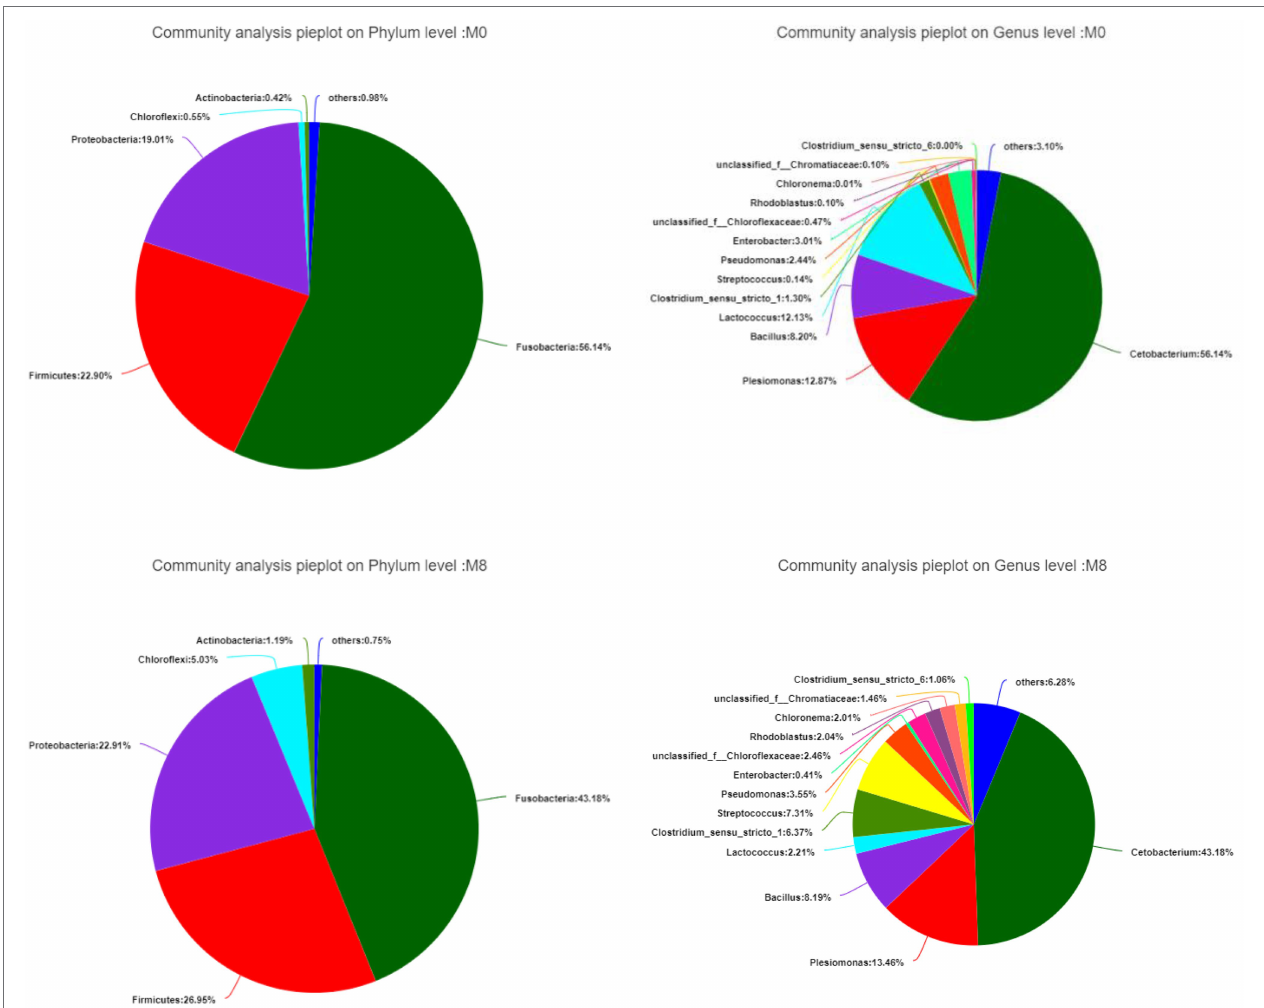
FIGURE 2 | Effects of methionine dietary restriction on gut bacterial composition at the phylum (left) and genus (right) levels after feeding for 8 weeks ( n =